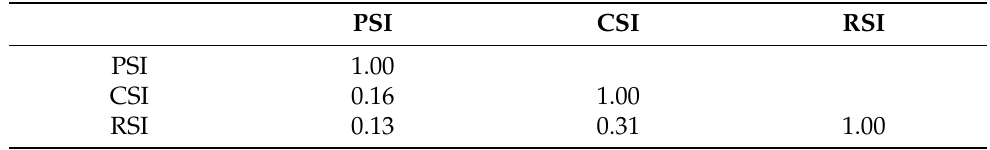
Table 3. Correlation coefficients for the